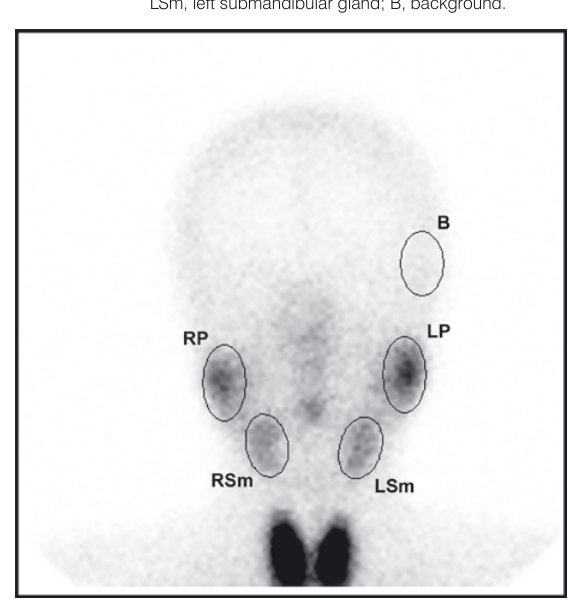
Figure 4. Schematic presentation of time–activity curve in normal pattern on salivary gland scintigraphy. Point a, initial shoulder, representing a vascular perfusion, or, in cases of an unclear shoulder, at 1 min; point b, the maximum count before stimulation; point c, the background count at the time of peak activity; point d, the minimum count after stimulation.